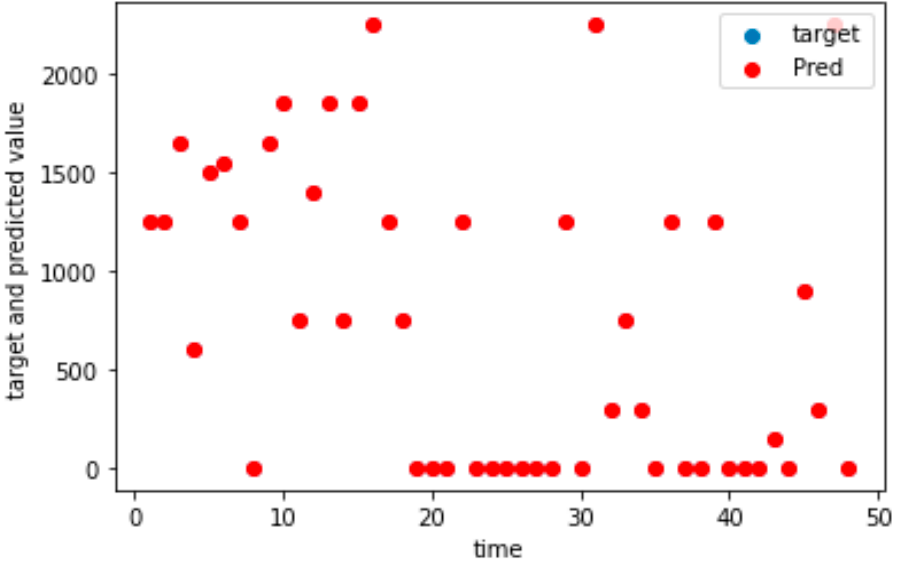
Figure 7. Typical Monday morning traffic in Leepavara (source: Google Maps). Note: In the above figure, red implies high traffic levels, amber implies moderate traffic levels, and green implies lower traffic levels.